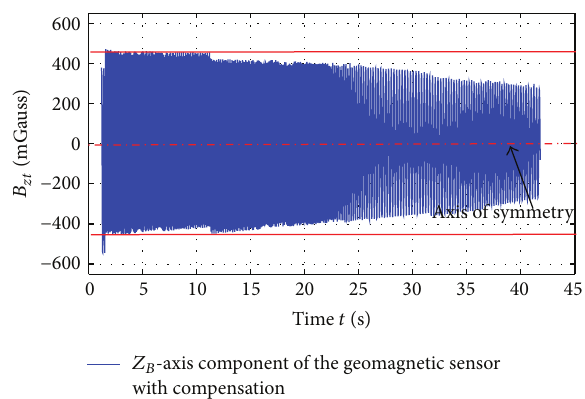
Figure 21: 𝑍 𝐵 -axis component of geomagnetic sensor with compen-